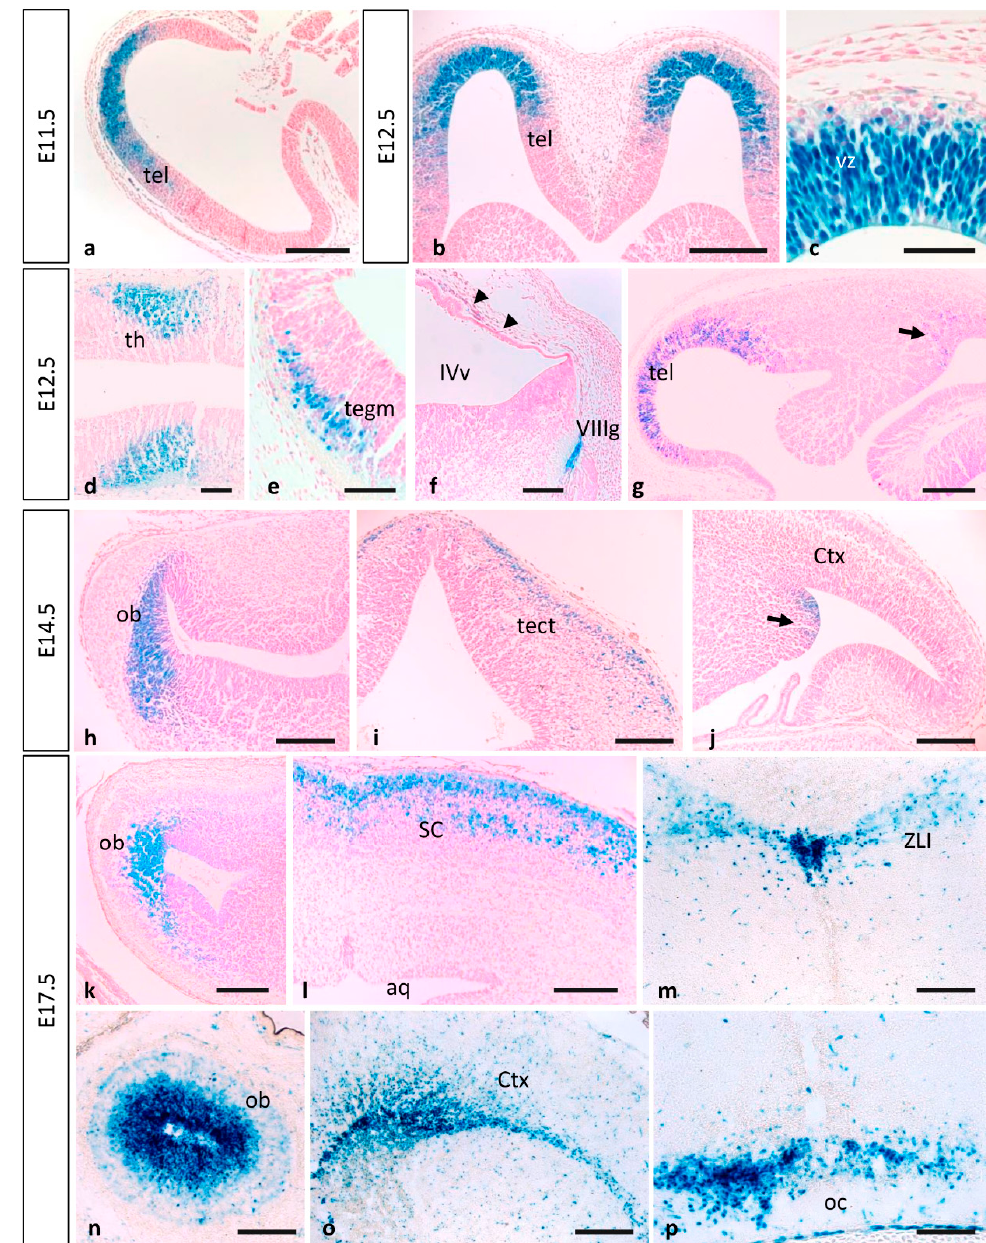
Figure 5. Expression of MT1-MMP in the developing mouse brain. β -gal staining of horizontal ( a – c , g , h , k ) and coronal sections ( n ) from E11.5 to E17.5 Mt1-mmp LacZ/+ embryos revealed high expression of MT1-MMP in the ventricular zone of the rostral telencephalon at early embryonic stages ( a – c , g ) that will give rise to the olfactory bulb later in development ( h , k , n ). In addition, β -gal positive cells were detected in the thalamus ( d ), the mesencephalon ( e ), the VIII nerve ganglia ( f ) and the meninges (arrowheads in f ). At this embryonic stage, β -gal stained cells appear in the caudal portion of the telencephalon (arrow in g ) where the amygdala will develop later (arrow in j ) at E14.5. LacZ-positive cells were also located in the mesencephalic tectum of E14.5 embryos ( i ) and restricted to the superficial layers of the superior colliculus by E17.5 ( l ). By this perinatal stage, strong LacZ staining localized in the periventricular zone of the III ventricle and the zona limitans intrathalamica ( m ) and the optic chiasm region ( p ). Streams of β -gal positive cells entered the cerebral cortex by E17.5 ( o ). Abbreviations: aq, cerebral aqueduct; Ctx, cerebral cortex; ob, olfactory bulb; oc, optic chiasm; tect, mesencephalic tectum; tegm, mesencephalic tegmentum; SC, superior colliculus; tel, telencephalon; th, thalamus; vz, ventricular zone; IVv, IV ventricle; VIIIg, VIII nerve ganglia; ZLI, zona limitans intrathalamica. Scale bars: 250 µ m ( a , b ), 200 µ m ( f – p ), 100 µ m ( d , e ), 50 µ m ( c